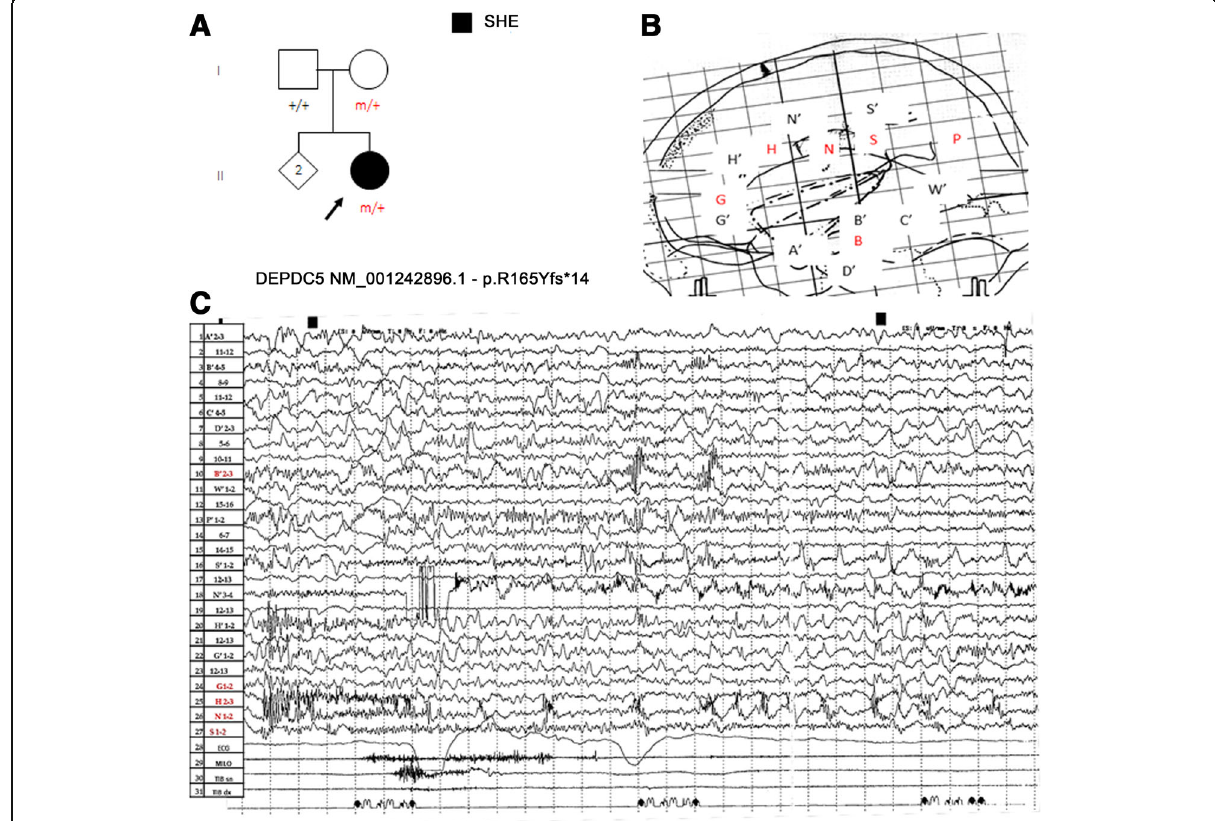
Fig. 3 a Pedigree of a 57-year-old female with a frameshift mutation of DEPDC5, p.Arg165Tyrfs*14 inherited by her healthy mother. Previously published in Ferri et al. 2017. b Stereotactic scheme of the patient who at age 43 years underwent stereoelectroencephalography (SEEG) study with bilateral limbic exploration extended to the inferior parietal lobe. The SEEG exploration shown (lateral view) included 15 intra-cerebral electrodes implanted mainly on the left. The EEG focus area was mainly explored by electrode H. Black letters with the accent (A ’ , B ′ , C ′ , D ’ , G ’ , H ′ , N ′ , S ′ , W ′ ) indicates left side; red letters (B, G, H, N, S, P) indicated the right. c SEEG ictal recording showing fast polyspike activity over both the anterior-mid cingulate gyrus preceding a typical nocturnal hypermotor seizure, prevailing on right central-anterior cingulate cortex (H electrode). Note that interictal activity is recorded also in electrodes remote from ictal onset zone. Although the electrical pattern was suggestive for focal cortical dysplasia, tailored brain MRI was